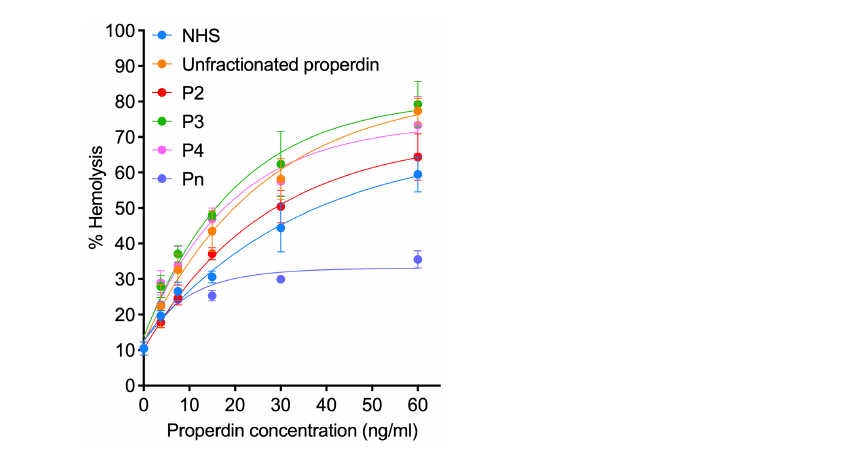
FIGURE 6 Properdin functional hemolytic assay does not detect greater function in higher order oligomers. Properdin function was quanti fi ed in unfractionated pure properdin and NHS, along with properdin oligomers separated from pure properdin (P n , P 4 , P 3 , and P 2 ), using a properdin